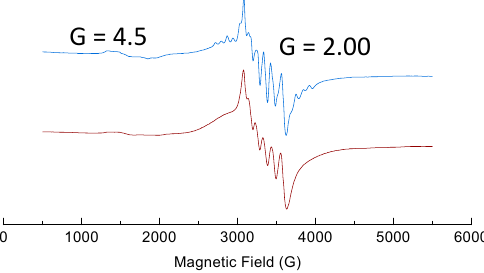
Figure 5. Electron paramagnetic resonance (EPR) study of manganese Complexes 1 (red line) and 2 (blue line) with 20 mM of H 2 O 2 in the presence of 20 mM of AcOH after 30 min.